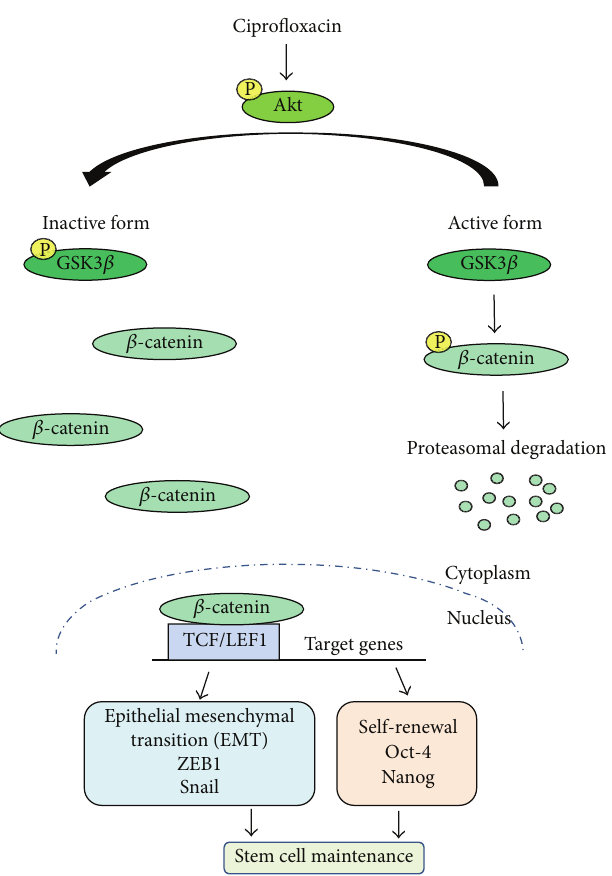
Figure 6: Schematic diagram summarizes the effects of CIP for improvement of the stemness in human DPCs. CIP improved the stemness of human DPCs through Akt activation which accounts for GSK3 𝛽 inactivation, resulting in the increase of cellular 𝛽 -catenin. As a consequence, 𝛽 -catenin accumulates in cytoplasm and translocates into nucleus leading to stimulation of target genes, including transcription factors associated with EMT and self-renewal that might exert the stemness sustaining effect of